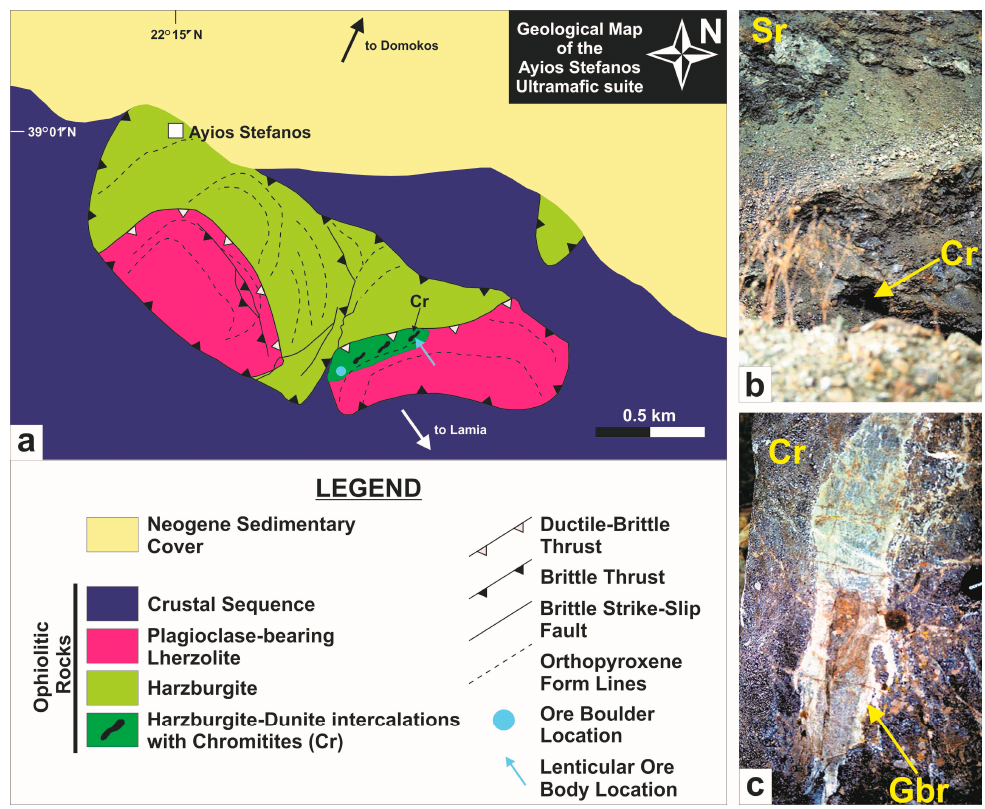
Figure 3. ( a ) Geological map of the Ayios Stefanos region illustrating the bowing of structures synchronous to ‘hot’ nappe emplacement [36]; ( b ) The serpentinized dunite-harzburgite ductile-brittle thrust zone that separates the peridotite nappes in the Ayios Stefanos area; ( c ) A gabbroic dyke in the chromitite boulder within the quarry talus (this figure also appears in [36]). Abbreviations (in order of appearance): Cr = chromitite gallery (in b) and chromitite (in c); Sr = serpentinite; Gbr = gabbroic dyke.